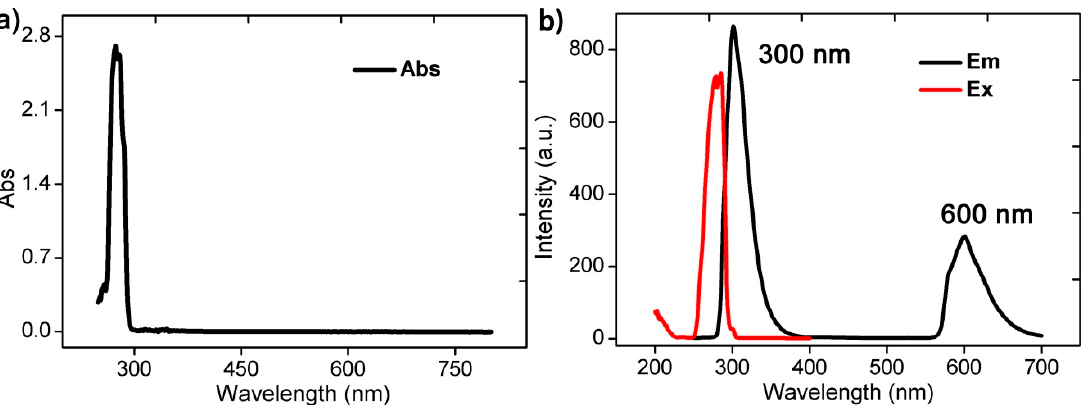
Figure 4. UV–Visible absorption spectroscopy ( a ) and photoluminescence spectrum ( b ) of the cluster Zn6 dissolved in N,N -dimethylformamide (DMF) at room temperature.